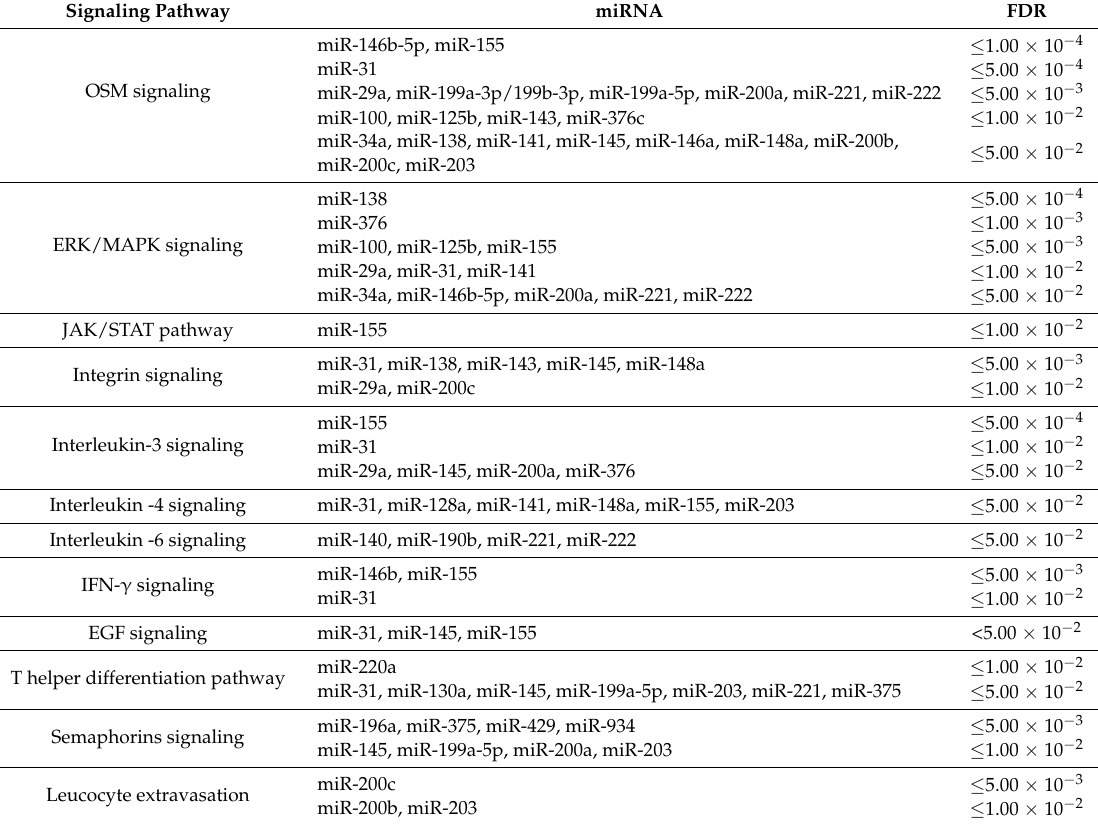
Table 2. The most relevant pathways related to miRNA–mRNA networks in breast cancer cell lines. Signaling